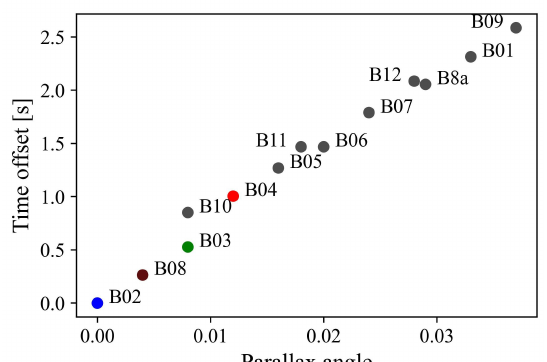
Figure 1. Temporal sensing offset and parallax angle [77] in relation to the blue band